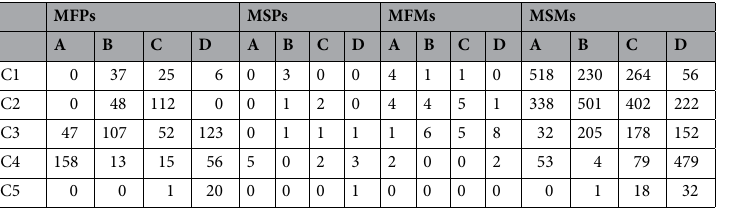
Table 4. Configurations of different axials in mandibular premolars and molars. MFPs: mandibular first premolars, MSPs: mandibular second premolars, MFMs: mandibular first molars, MSMs: mandibular second molars.